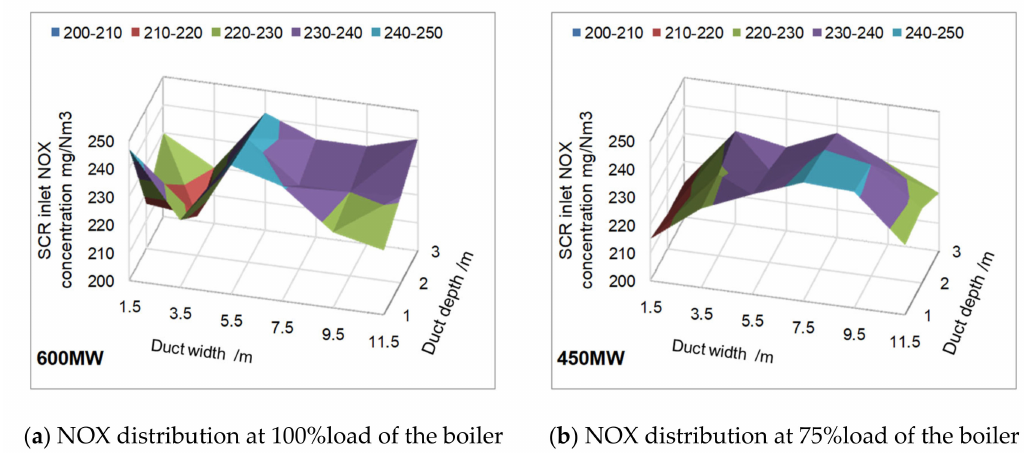
Figure 8. NOX distributions at SCR inlet of the 600 MW unit at di ff erent